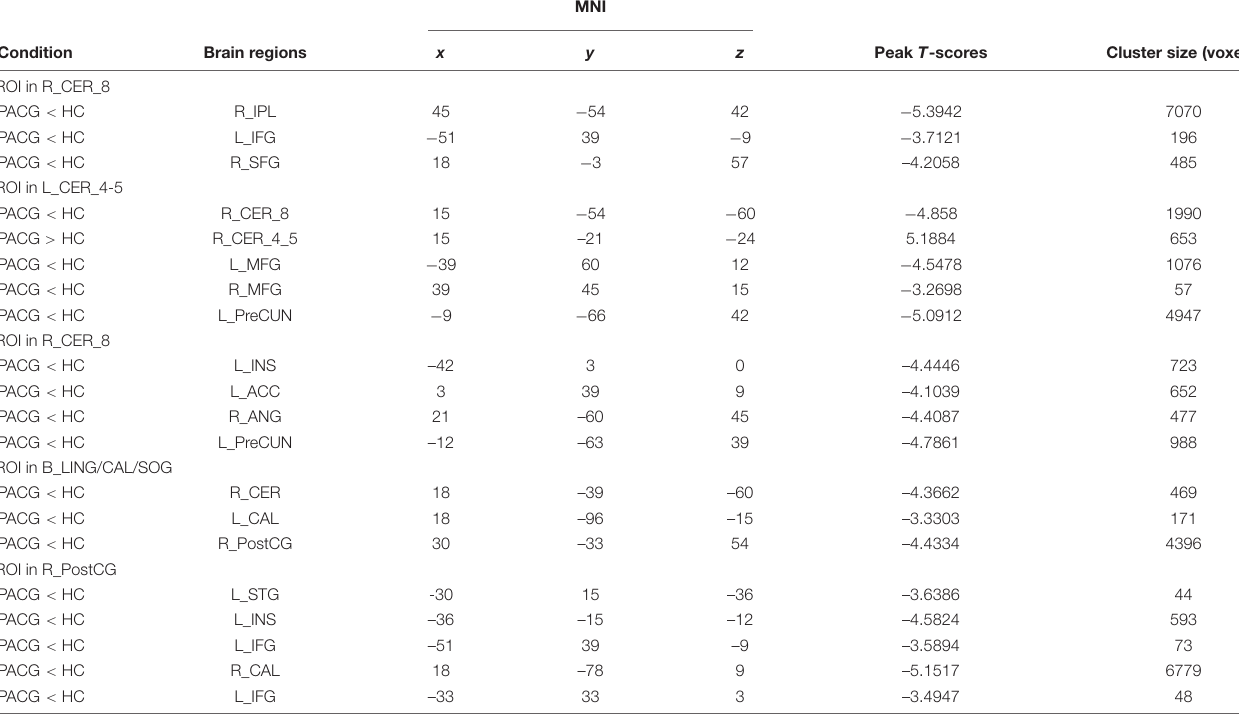
FIGURE 2 | Different ReHo between the PACG and HC group. The red denotes higher ReHo values, and the blue areas indicate lower ReHo values (voxel-level p < 0.01, GRF correction, cluster-level p < 0.05) (A) . The mean of altered ReHo values between patients with PACG and HCs (B) . ReHo, regional homogeneity; PACG, primary angle-closure glaucoma; HC, healthy control; CER, cerebellum; LING, lingual gyrus; CAL, calcarine; SOG, superior occipital gyrus; PostCG, postcentral gyrus. TABLE 3 | Significant differences in the functional connectivity (FC) between two